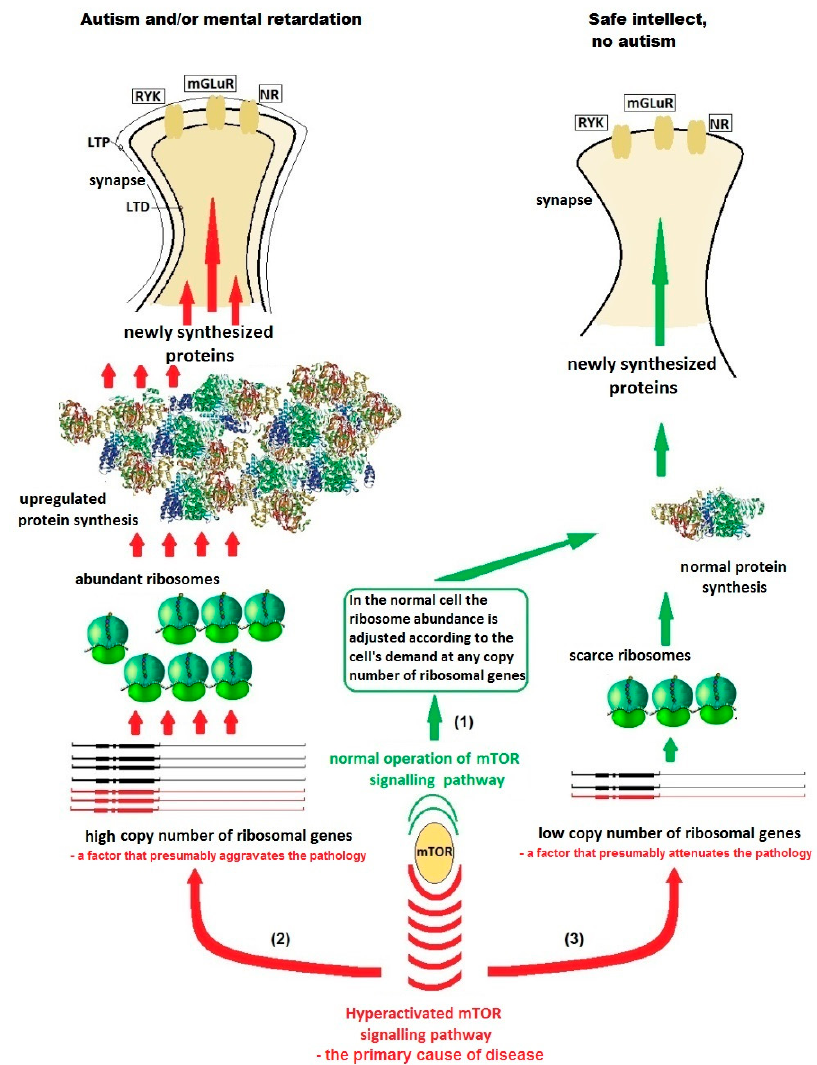
Figure 2. A hypothetical scheme of the influence of ribosomal gene (RG) dosage in the genome of a non-carrier (green text and arrows) and a carrier (red text and arrows) of a monogenic autism mutation on the disease severity. The idea is that low RG copy numbers that lead to ribosome underabundance would attenuate the signs of monogenic autism caused by excessive protein production in the